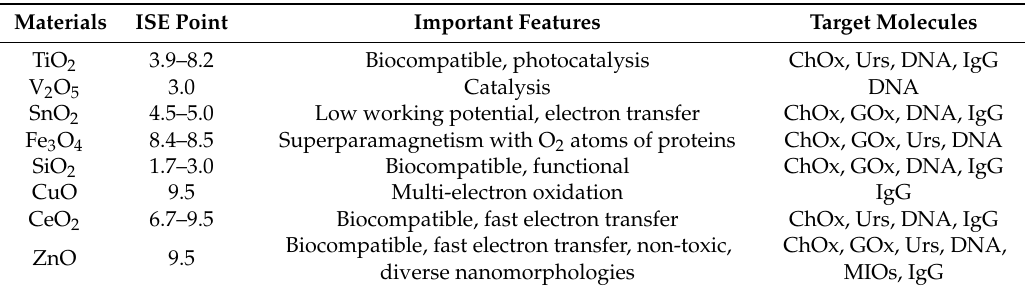
Table 1. Metal oxides with their isoelectric points (ISE), important features, and target molecules for biosensing applications (ChOx, Cholesterol; GOx, Glucose; IgG, Immunoglobulin; Urs, Urea; MIOs, Metallic ions). Materials ISE Point Important Features Target